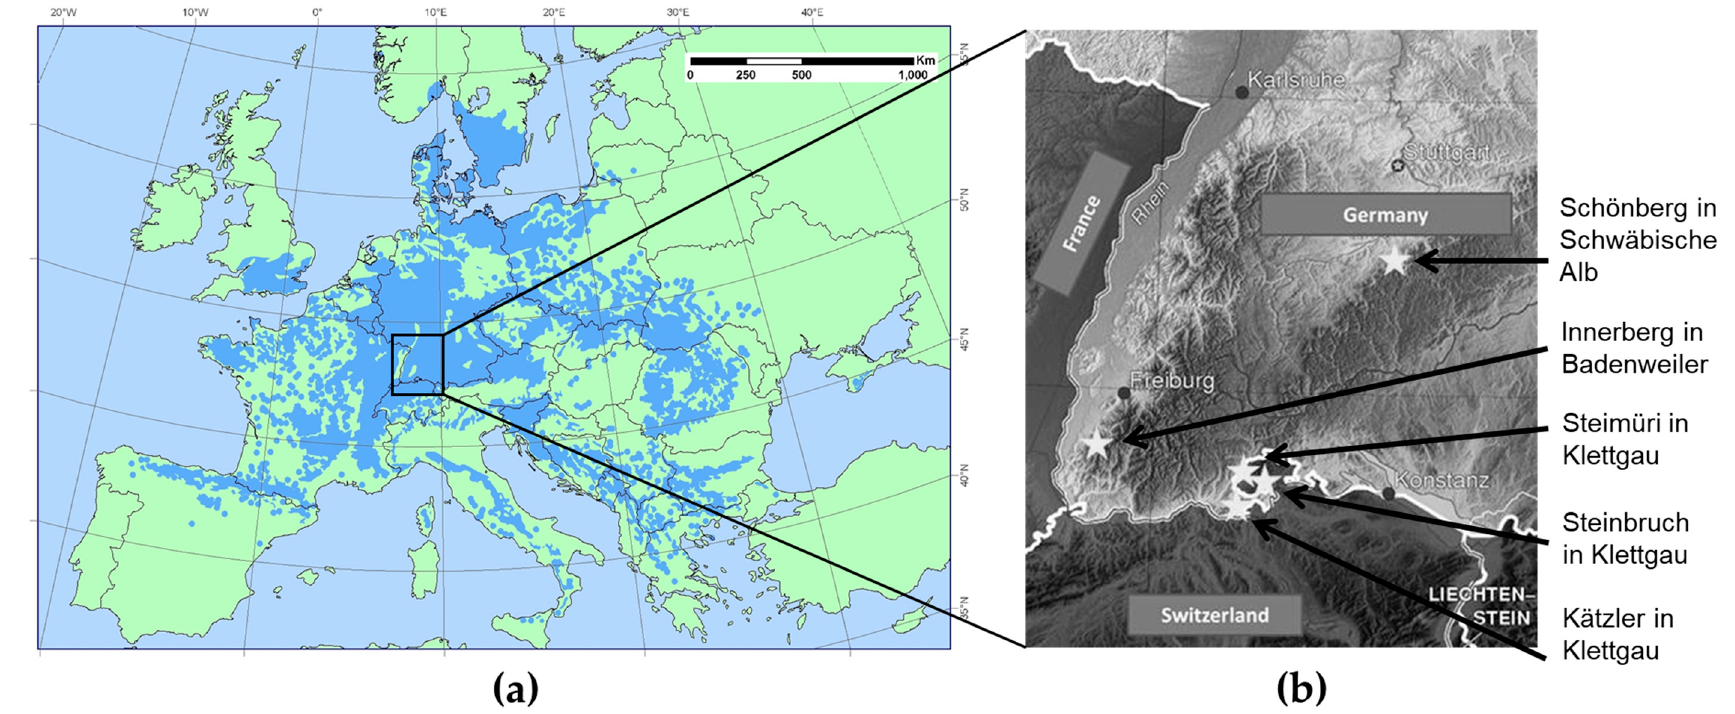
Figure 1. ( a ) Natural distribution area of European beech ( Fagus sylvatica L.) (reproduced from the distribution map of Beech ( Fagus sylvatica L.) by the European Forest Genetic Resources Program—EUFORGEN 2009) with the location of the study area; ( b ) location of the five forests as study areas in Germany and Switzerland.